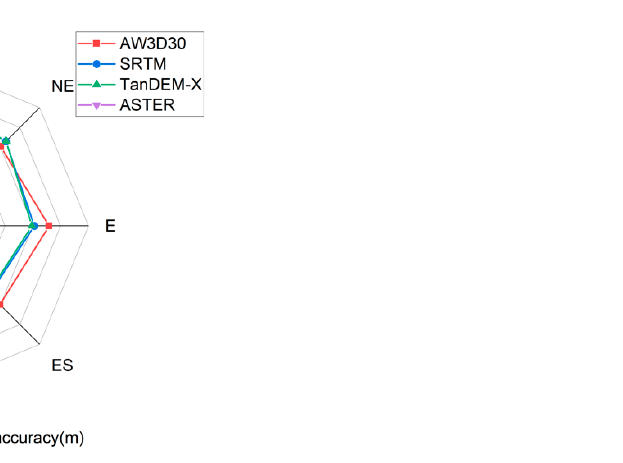
Figure 5. Radar plots of ME for four DEMs classified by slope aspect across all study areas: AW3D30, SRTM, TanDEM-X, and ASTER.